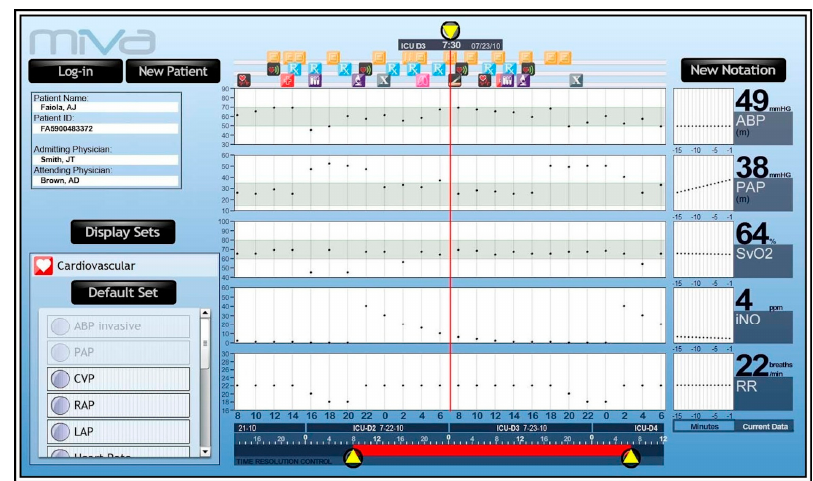
Figure 13. MIVA: Interactive visualization tool to show the temporal change of numerical values where each variable is represented by an individual point plot. Source: image courtesy of Antony Faiola.